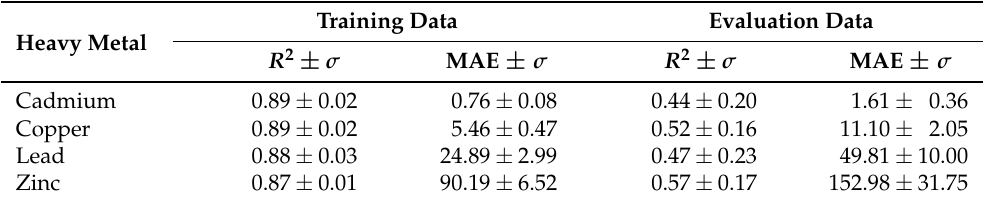
Table 3. Standalone spatial interpolation model via Gaussian process.